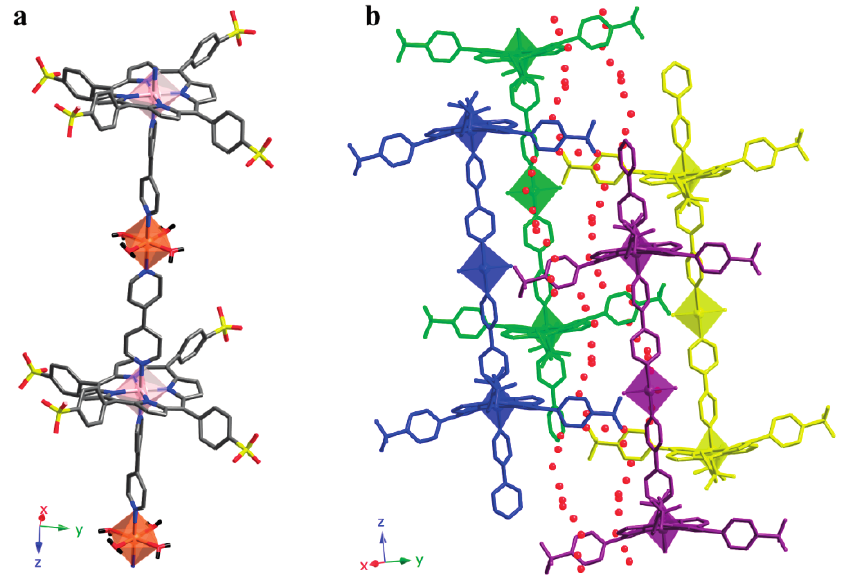
Figure 9. ( a ) Detail of the structure showing the extension of the 1D polymers and ( b ) relative position of the chains for compound 5 . Crystallization molecules of water are shown in red. (Co(1) (TPPS): pink, Co(2): orange, C: grey, N: dark blue, O: red, S: yellow). H atoms have been omitted for